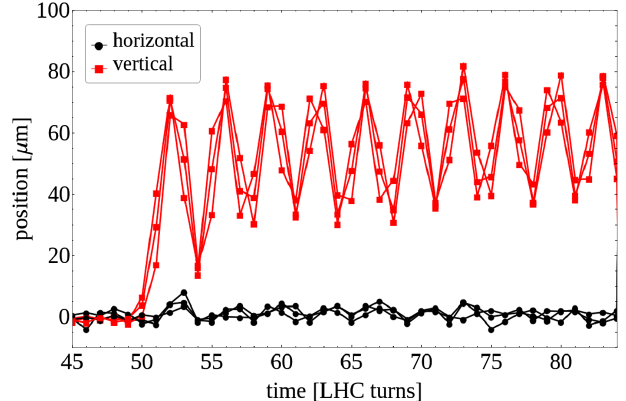
FIG. 4. Orbit offset measured by a beam position monitor in IR4, for three bunches after the discharge of all the QH circuits in one normal dipole magnet. The beam energy was 3.46